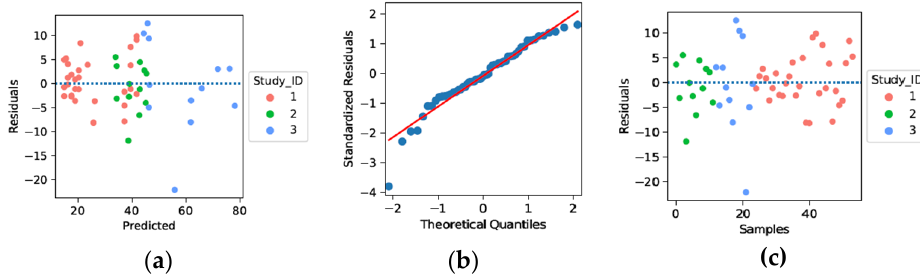
Figure 6. Diagnostic plots for linearity assumption on Ridge–Chewiness. Study_ID 1: [21], Study_ID 2: [19], Study_ID 3: [20]. ( a ) Validation of linearity, homoscedasticity assumptions by plotting residuals vs predicted; ( b ) Demonstration of normality assumption by Q-Q plot of standardised residuals; ( c ) Validation of independence of observations by plotting residuals vs row values of samples.